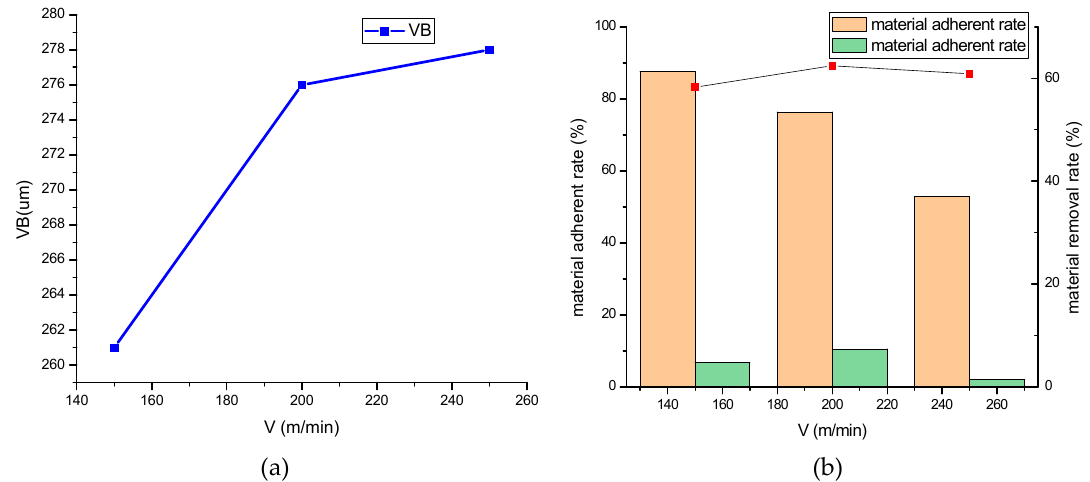
Figure 8. Wear and tool surface conditions. ( a ) Tool wear with cutting speed; ( b ) material adhesion rate and removal rate.